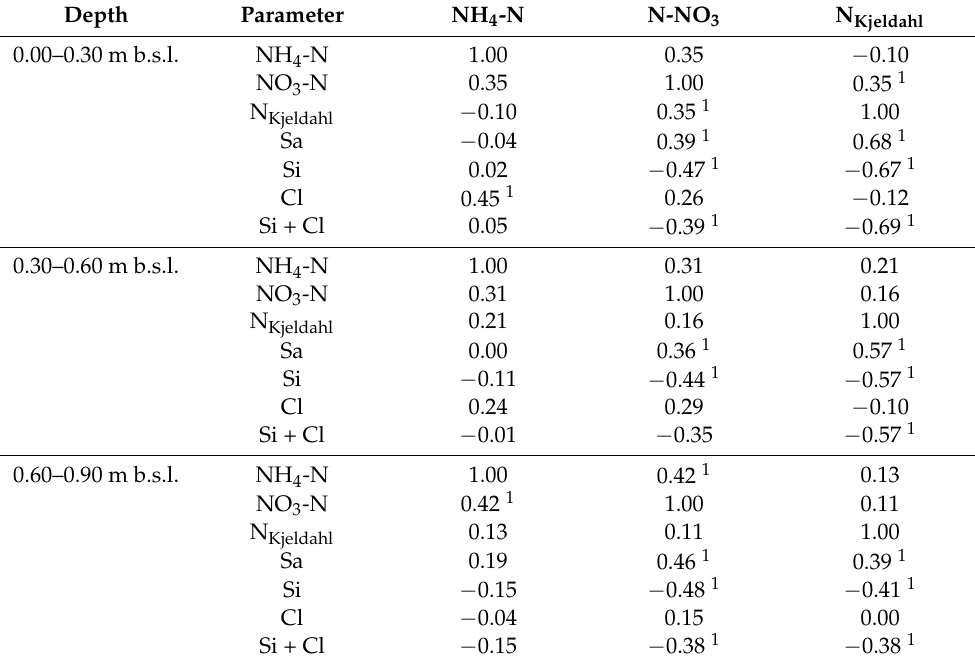
Table 6. Spearman correlation between the content of N forms and soil fractions at different depths; after uniform fertilization